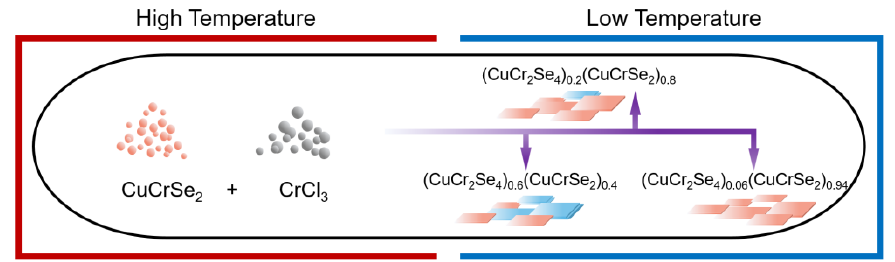
Figure 1. Schematic of the double zone CVT growth furnace and the growth parameters of single CuCrSe 2 -CuCr 2 Se 4 crystals.